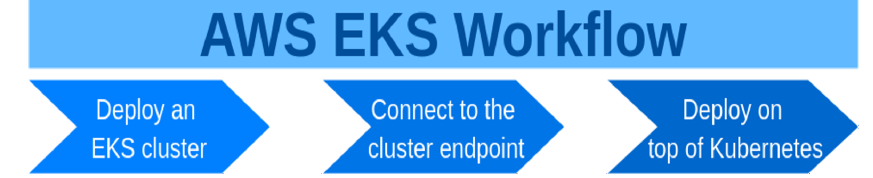
Figure 2. Schema presenting the stages of working with AWS EKS.